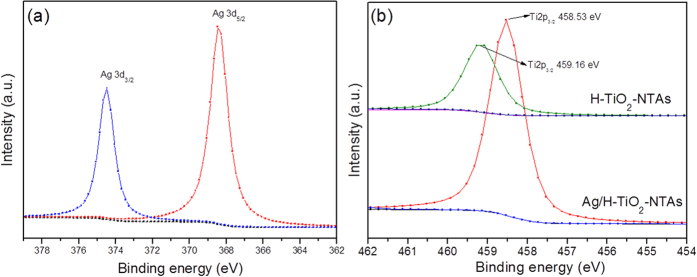
XPS analysis.High resolution XPS of (a) Ag 3d of 20s-Ag/H-TiO2-NTAs and (b) Ti 2p of H-TiO2-NTAs and 20s-Ag/H-TiO2-NTAs.